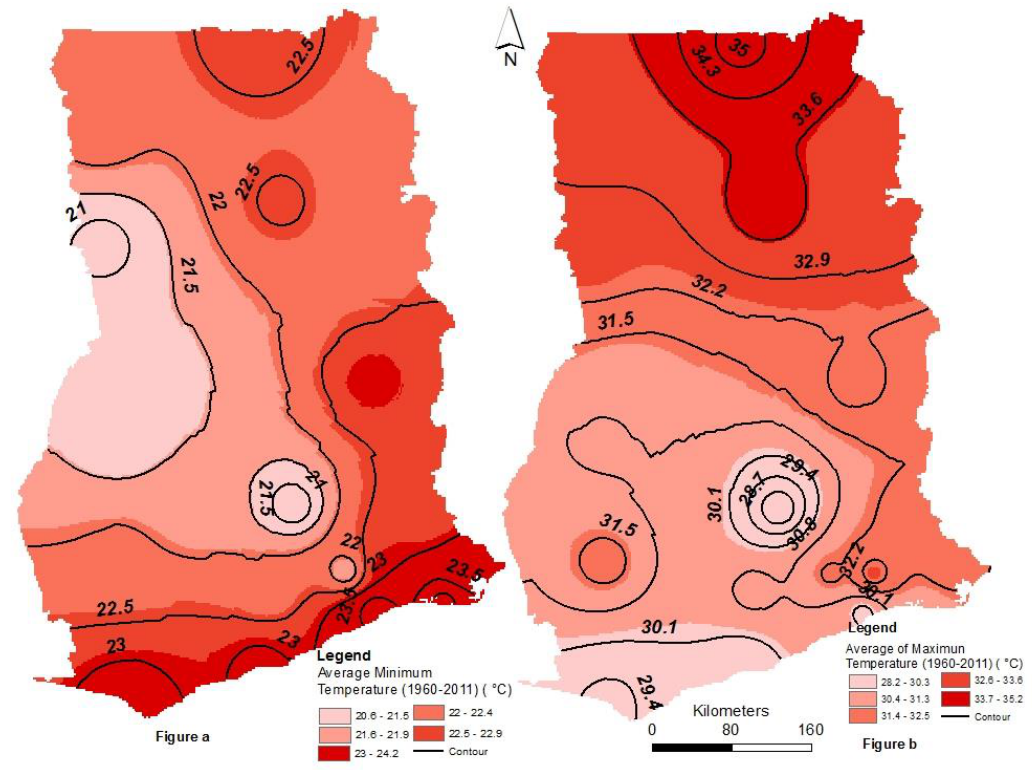
Figure 8. Spatial distribution of Minimum temperature ( a ) and Maximum temperature ( b ) from 1960 to 2011. The Inverse Distance Weighting (IDW) approach was used for the interpolation.